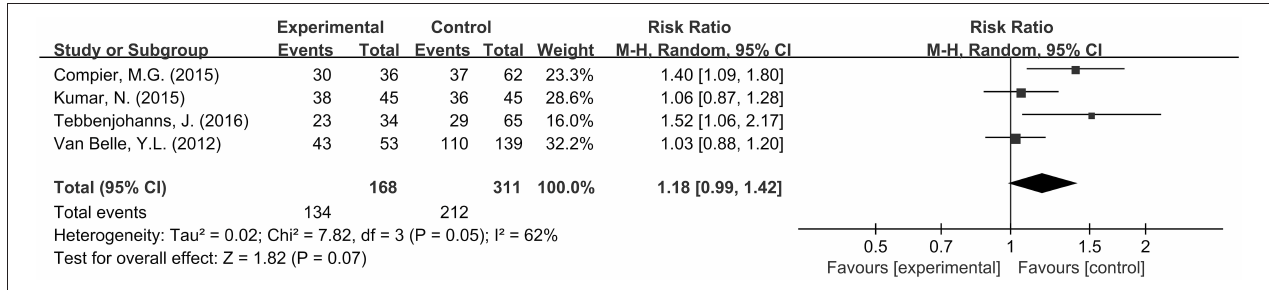
FIGURE 7 | Subgroup analysis for CB-2G.